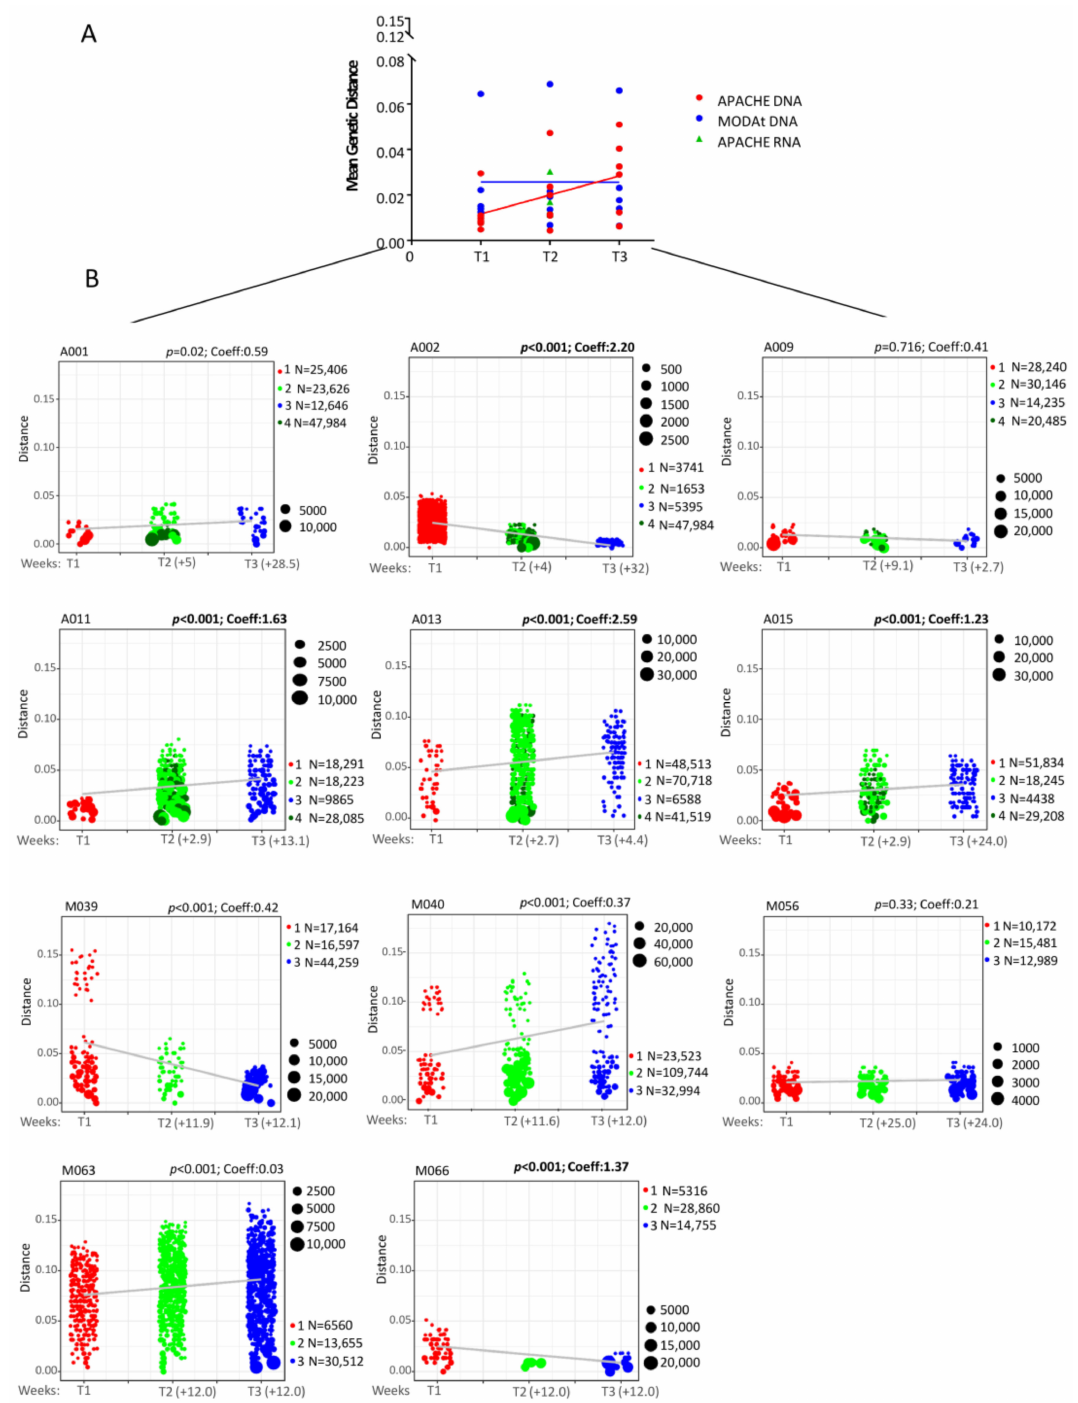
Figure 2. Change in HIV DNA molecular diversity ( A ) and C2-V3-C3 pairwise distance estimated for all samples in APACHE and MODAt individuals ( B ). ( A ) Mean pairwise distance was estimated for all samples within C2-V3-C3 region in APACHE (red dots for DNA and green dots for RNA) and MODAt (blue dots) individuals. For each sample, the means of all pairwise Tamura-Nei 93 (TN93) distances among sequences were computed to quantify nucleotide diversity. p -value T1 vs. T3: Wicoxon-test; p -value T1 vs. T2 vs. T3 Friedman tests. ( B ) For each sample, the means of all pairwise Tamura-Nei 93 (TN93) distances among sequences was defined to quantify nucleotide diversity. p -value T1 vs. T3: Mann-Whitney test and Cohen’s delta coefficient. Samples with a C2-V3-C3 pairwise distance characterized by a Cohen’s delta coefficient >0.8 and by a p -value < 0.05 were shown in bold. The time (weeks) from T1 to T2 and from T2 to T3 were reported for each patient. The black dots represent the abundance, Ns represent the numbers of